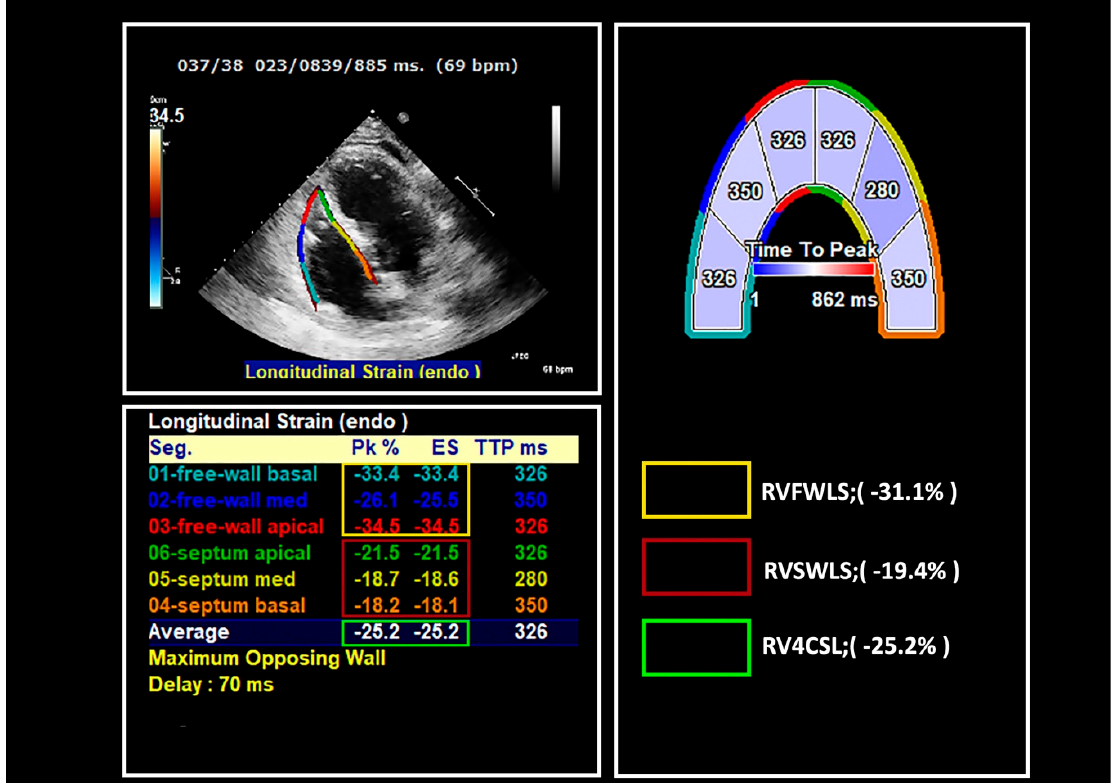
Figure 4. Right ventricle strain measurement. Region of interest of the right ventricle (RV) was defined by the endocardial border at the lateral tricuspid annulus level to the medial tricuspid annulus level. Then, the software automatically divided the apical right chamber views in 6 segments (three separate basal, mid and septal RV free wall strain traces, and three separate basal, mid and septal RV septal wall strain traces) and mathematically calculated RV global 4-chamber contour (RV4CSL) by averaging values of equal segment strain. Peak strain was defined as the peak value during entire heart cycle that may coincide with end-systolic peak or may appear after aortic valve closure. End systole (ES) was defined by the tricuspid valve opening time or by nadir of volume curve as surrogate. Segmental longitudinal strain curves. Note, free-wall strain segments are usually higher than septal strain segments.